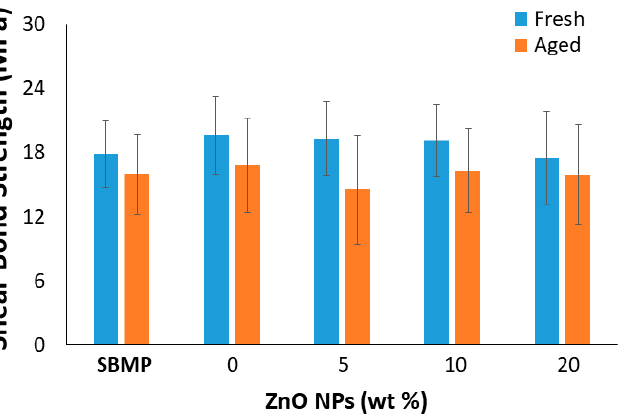
Figure 5. The shear bond strength (SBS) of the methacrylate-based resin blends ( n = 12).